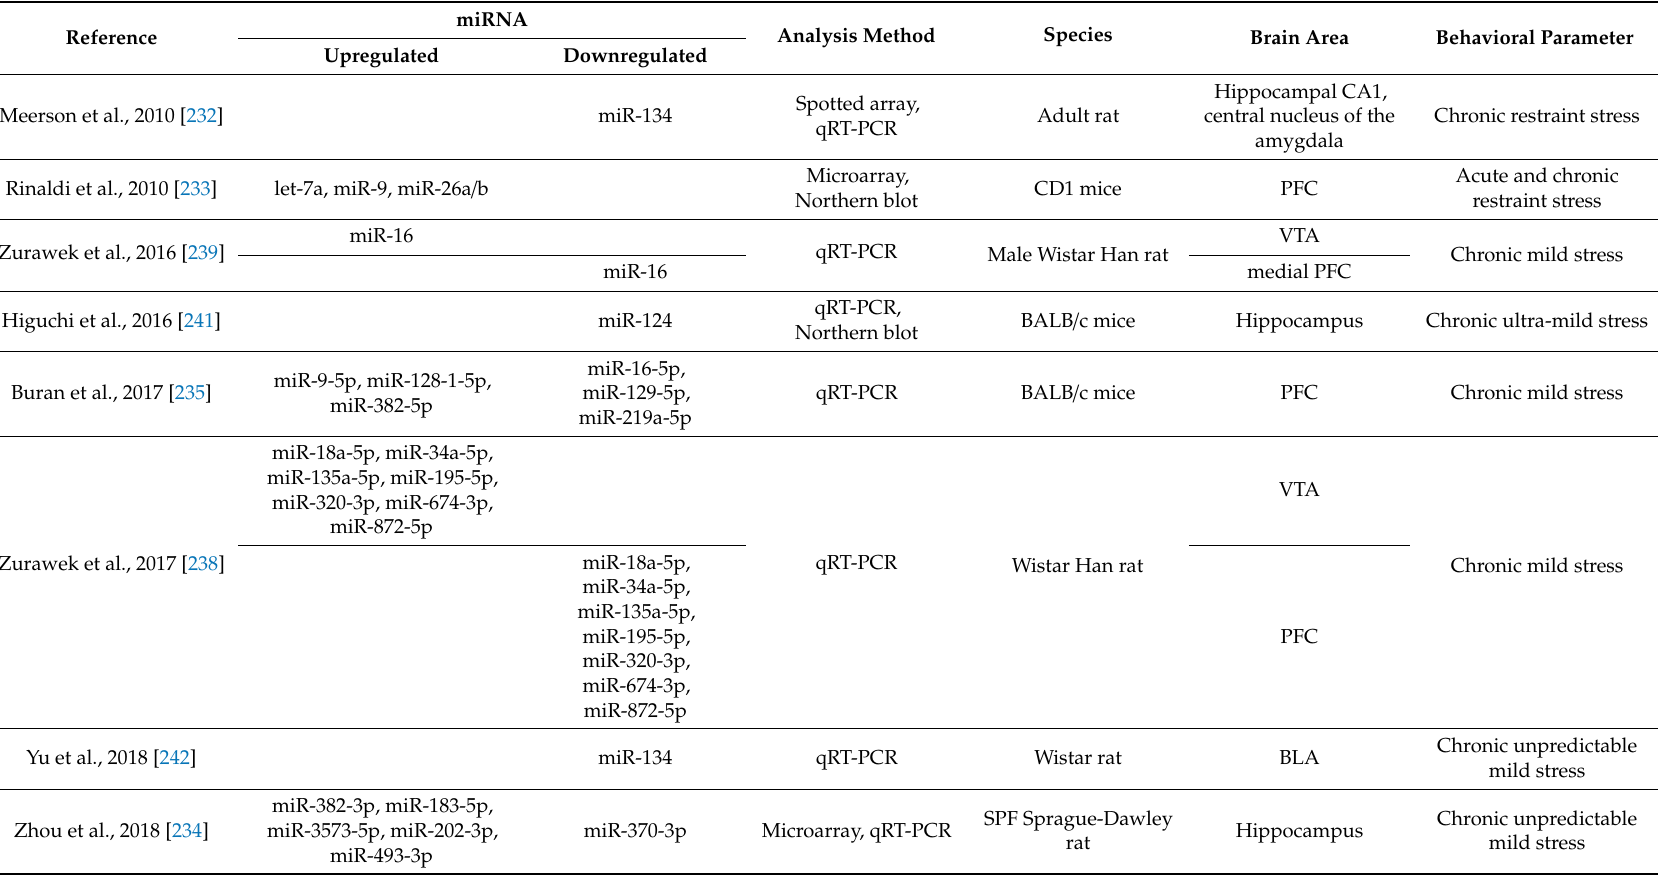
Table 1. Stress-induced changes in micro RNA